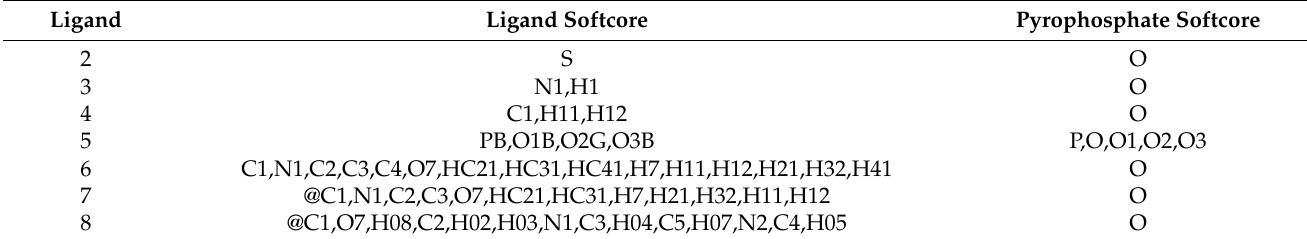
Table 2. Atoms selected as softcores for thermodynamic